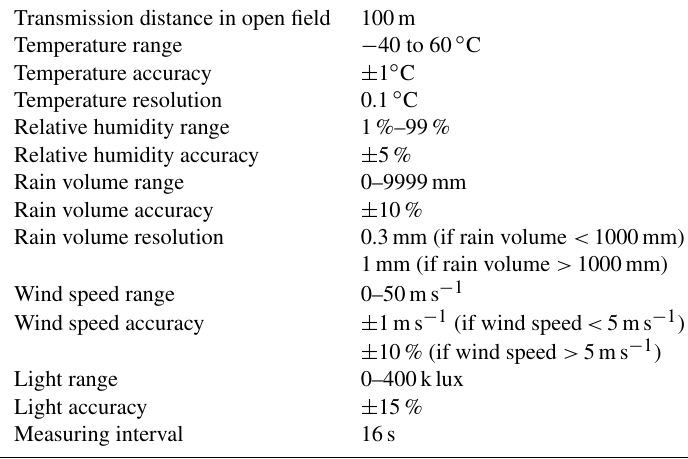
Table A1. Technical specifications of the Fine Offset WH2600 weather station, as given by the